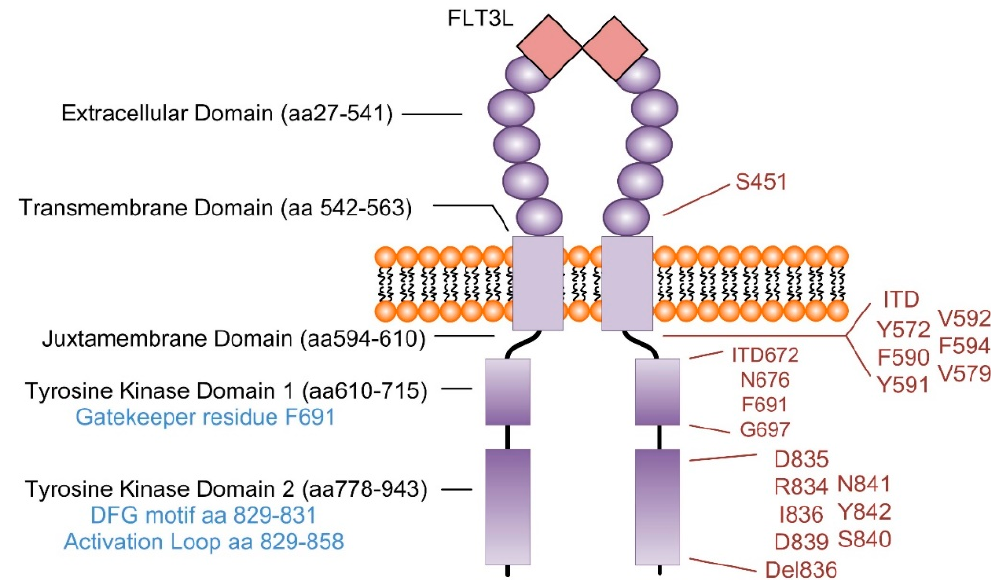
Figure 1. Domains and AML-associated mutations of the FLT3 receptor tyrosine kinase. The FLT3 kinase is a 993 amino acid protein comprised of extracellular, transmembrane, juxtamembrane, and split kinase domains. Mutations which have been reported in AML are notated on the right-hand side of the figure. Figure created using data from references [11,14,20–29].